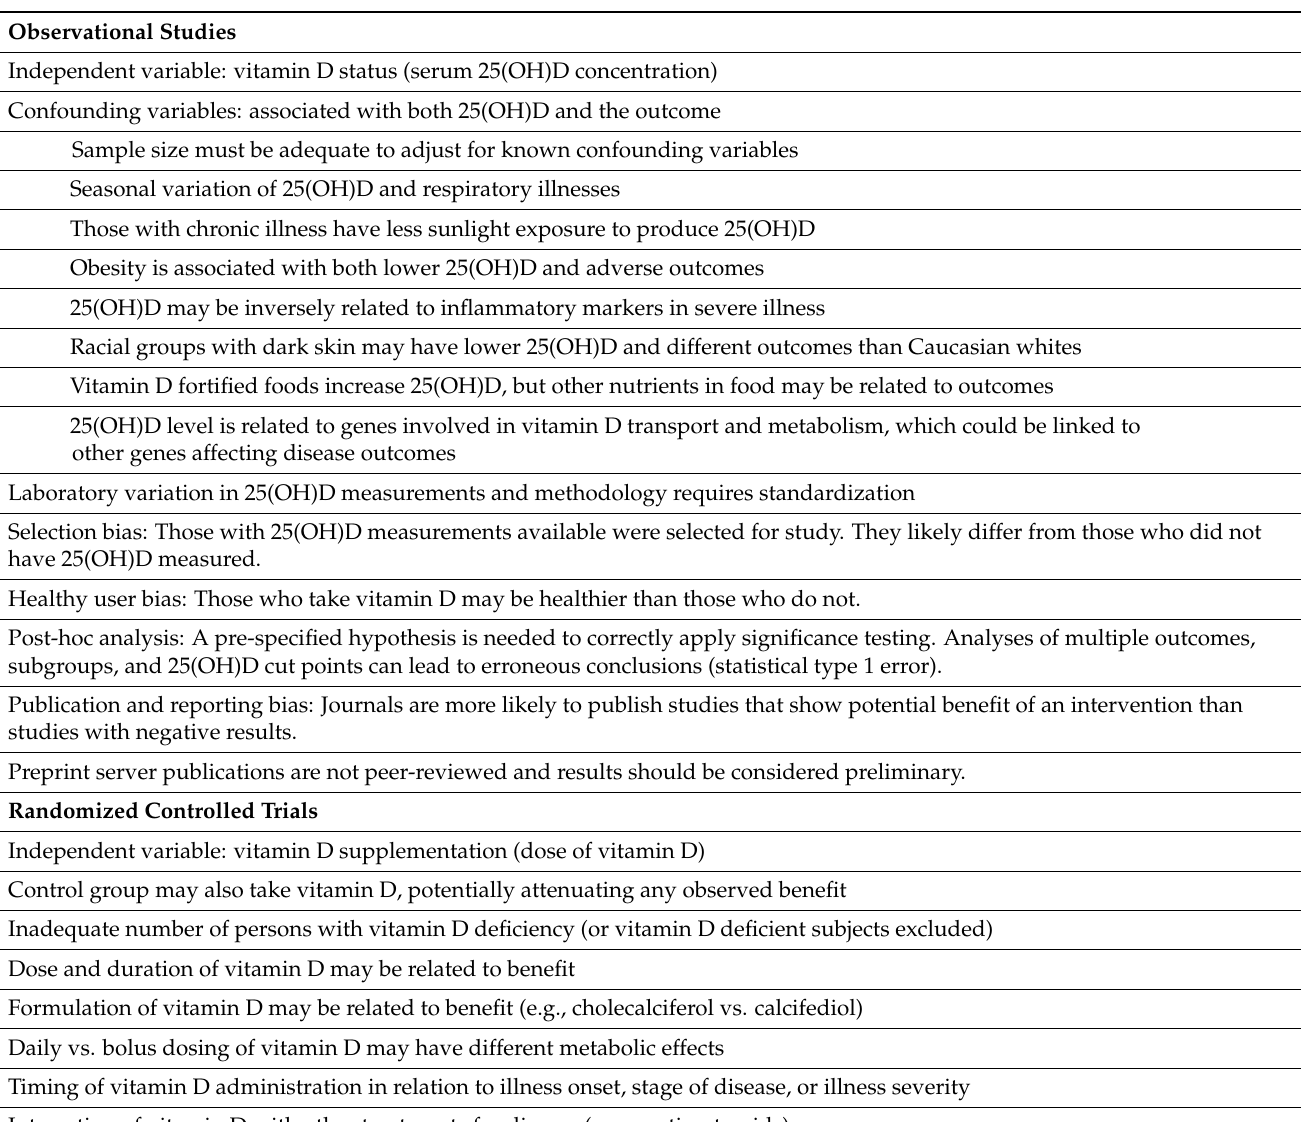
Table 1. Selected Limitations to be Considered Related to Study Design in Vitamin D and